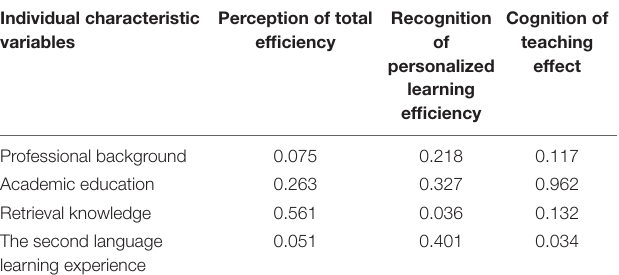
TABLE 4 | Variance test of the cognitive impact of the knowledge and experience of the changed subjects on the efficiency of the change of the second language learning model of Chinese students in the post-epidemic